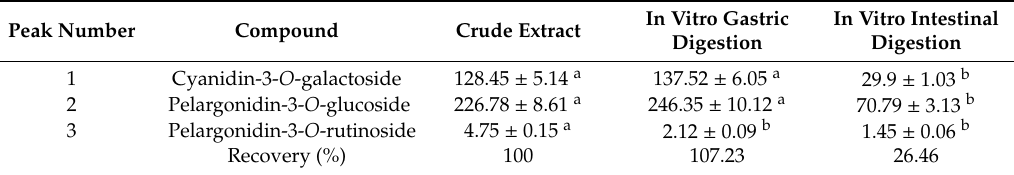
Table 1. Anthocyanin identification and quantification (mg/L) of Cornelian cherry fruit extract samples before and after in vitro digestion.